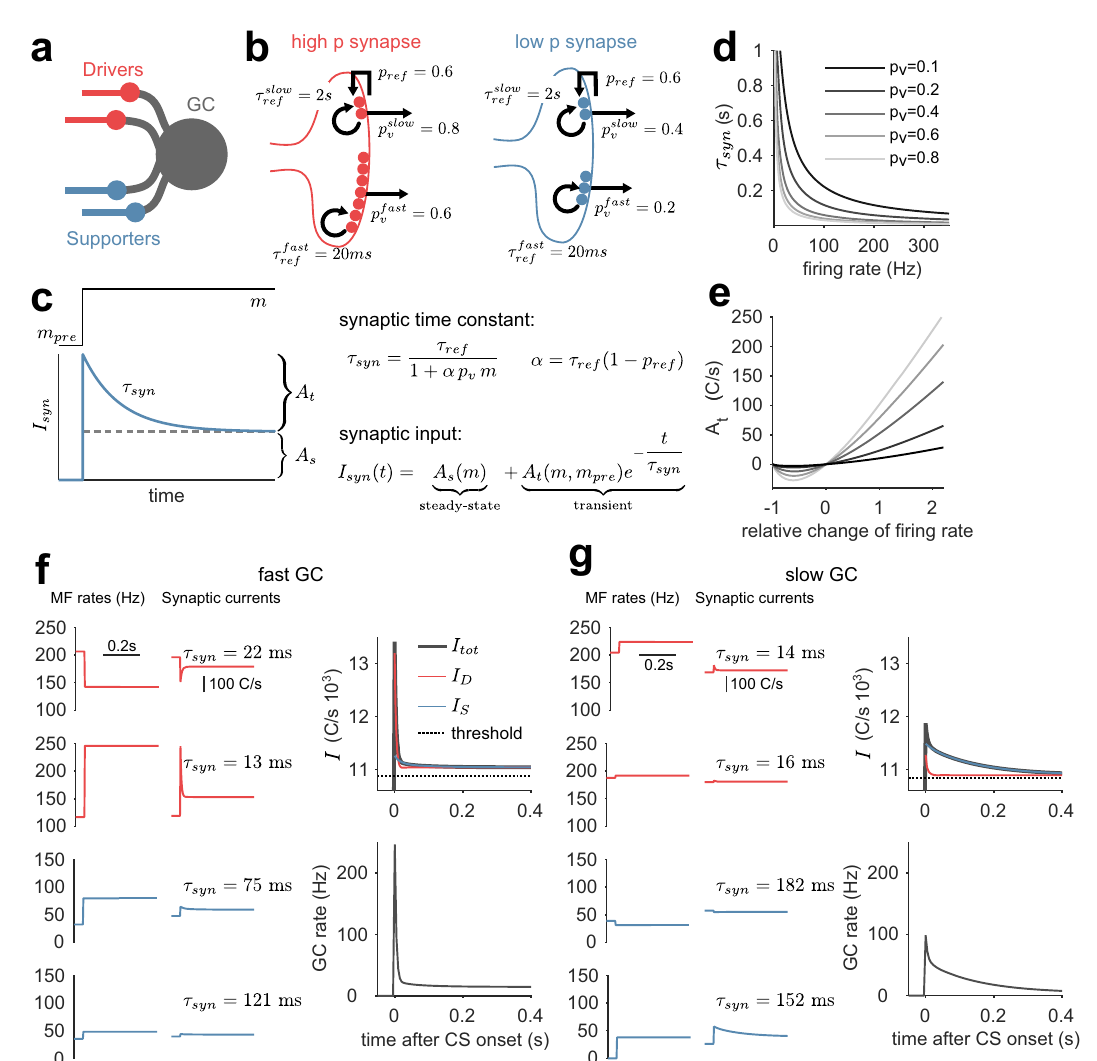
changeforabaseline fi ringrateof80Hz(m − m pre / m pre , m pre =80Hz).AnegativeA t corresponds to a transient decrease in fi ring rate. Same color code as in ( d ). f SamplefastGC.Left:driverandsupporterMF fi ringratesdrawnfromthresholded normaldistributions( N thr (200Hz,15Hz)and N thr (25Hz,15Hz),respectively)and the corresponding synaptic responses. For clarity, only the τ syn of the respective slowpoolisindicated.Upperrightpanel:GCthreshold(dashedline),totalsynaptic input (blackline), totaldriverinput(red line),and totalsupporterinput (blue line). The transient response is dominated by the driver input (red). Lower right panel: resulting GC fi ring rate response. g Like( f ) but for a sample slow GC. The transient response is dominated by the supporter input